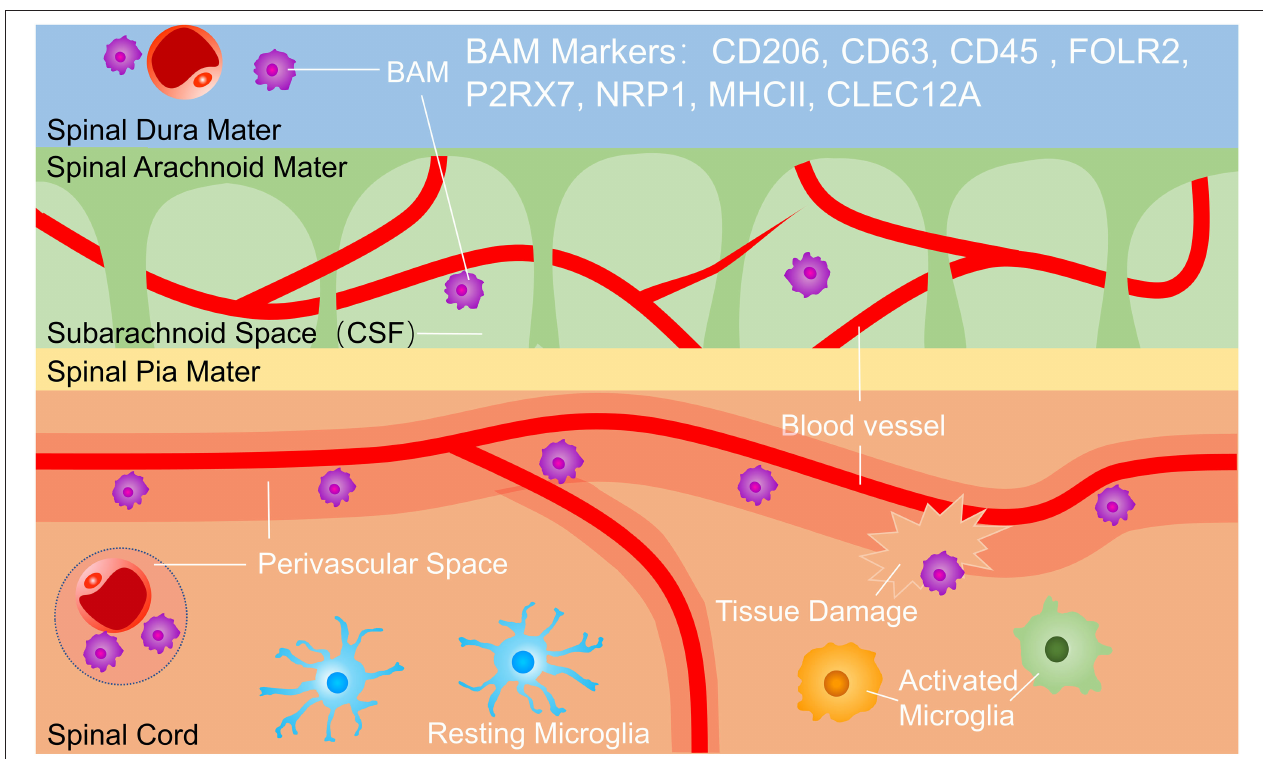
FIGURE 1 | Microglia and border-associated macrophages (BAMs). BAMs reside in the dura, subarachnoid space and perivascular space. BAM markers include CD206, CD63, CD45, FOLR2, P2RX7, NRP1, MHC II, and CLEC12A, and BAMs function in immunological surveillance, phagocytosing debris, presenting antigens, and controlling the exchange of cells and cytokines between the central nervous system (CNS) and bloodstream. BAMs, border-associated